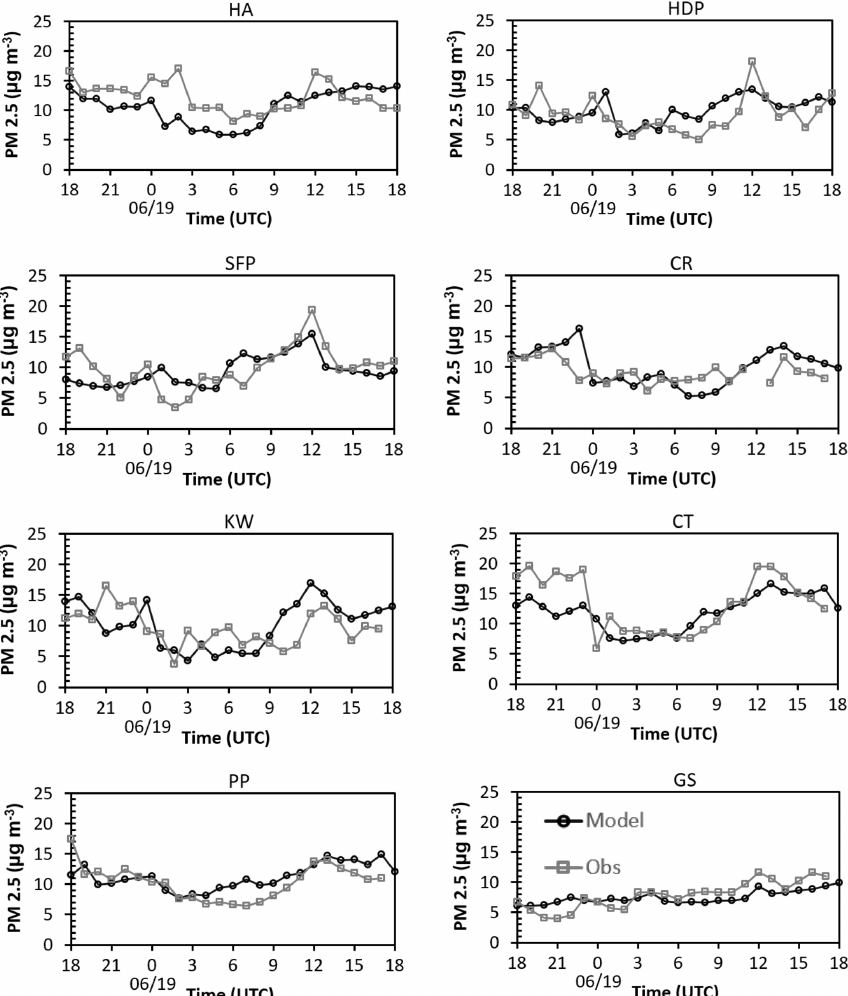
Figure 4. Site-by-site comparisons of hourly PM 2 . 5 mass concentrations (unit: µgm − 3 ) from D1_MOR_anth and the TCEQ site observations over 24h from 18:00 UTC on 18 June 2013 to 18:00UTC on 19 June 2013 (1d before the convection